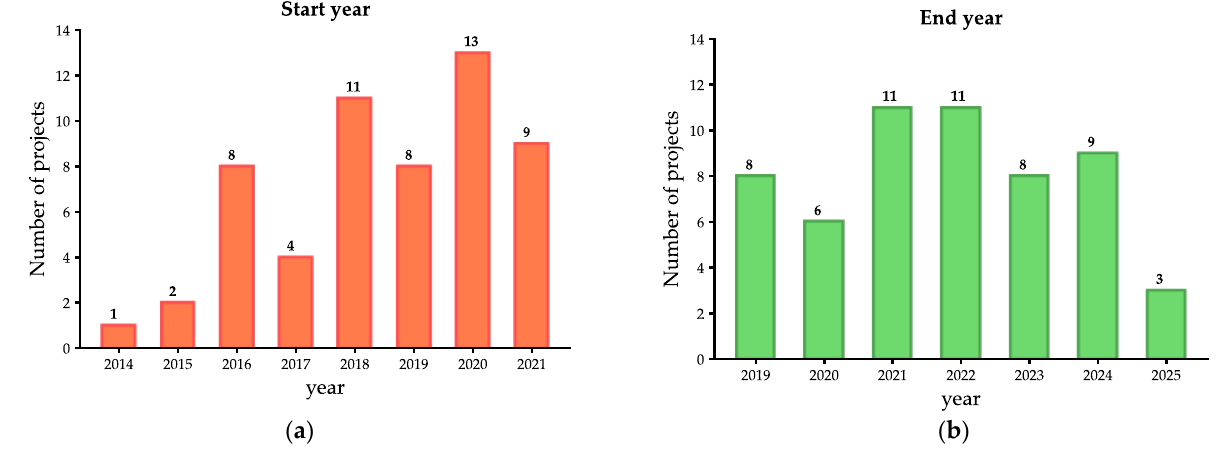
Figure 6. Number of projects per ( a ) start year and ( b ) end year.